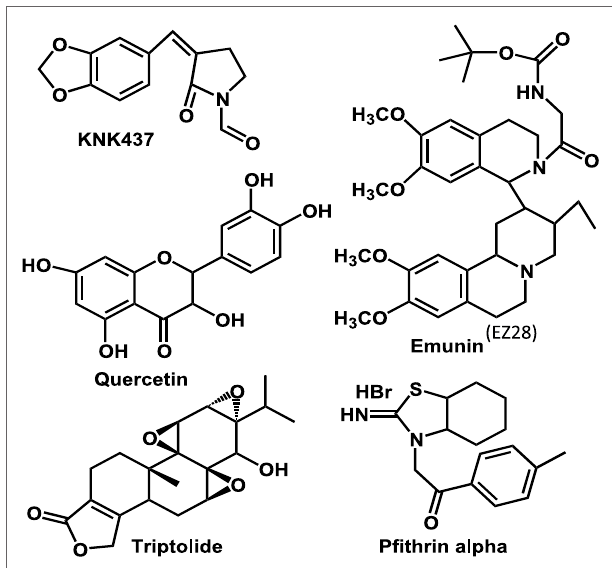
Figure 2 | Molecular structures of heat-shock factor-1 (HSF-1) inhibitors currently